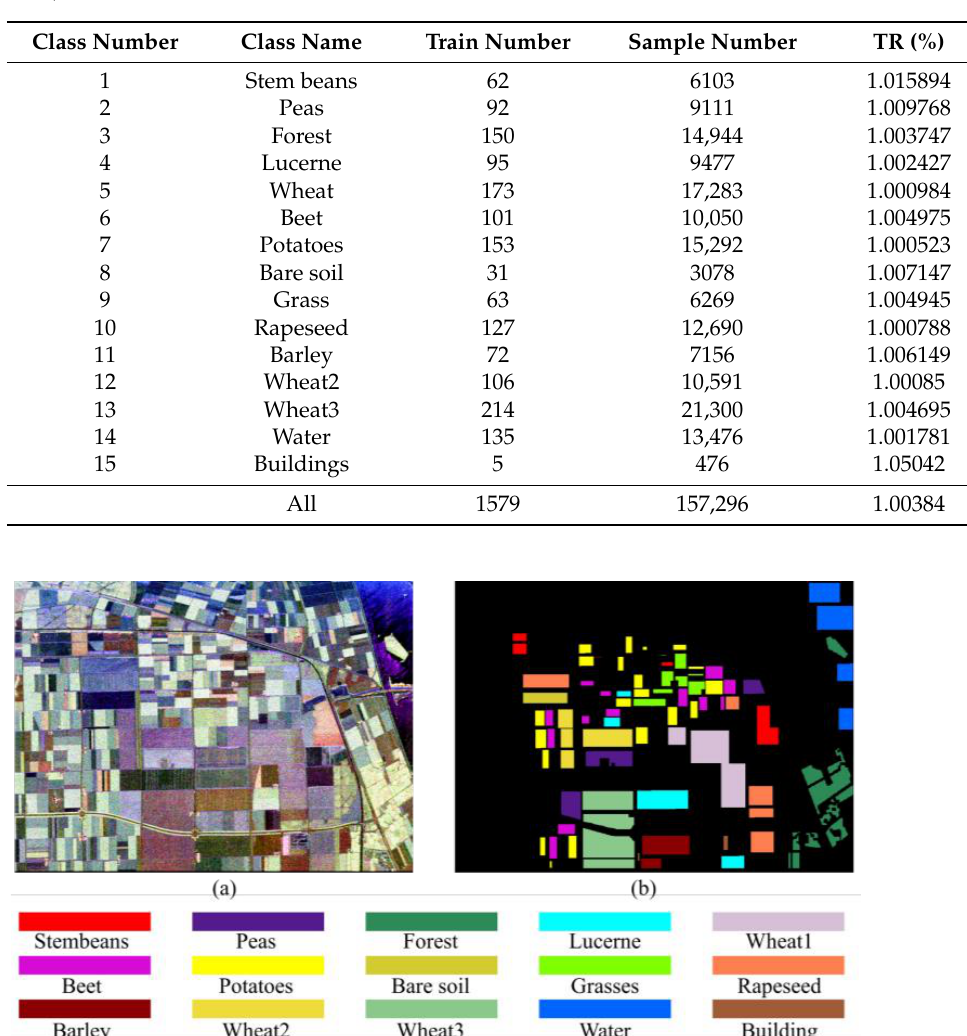
show the Pauli RGB pseudo-color image and GT. The image has a resolution of 6.6 meters (m) in range and 12.1 m in the azimuth direction. Table 1. Details of classes and training samples for AIRSAR Flevoland data (TR represents training ratio).